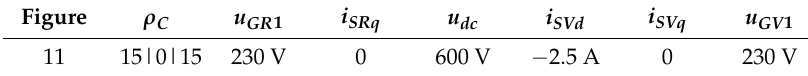
Figure 11. Capacitor voltage balancing experimental result, CH1: u C 1 ; CH2: u C 2 ; CH3: u C 3 ; CH4: u C 4 ; 100 V/div; 2.5 s/div.